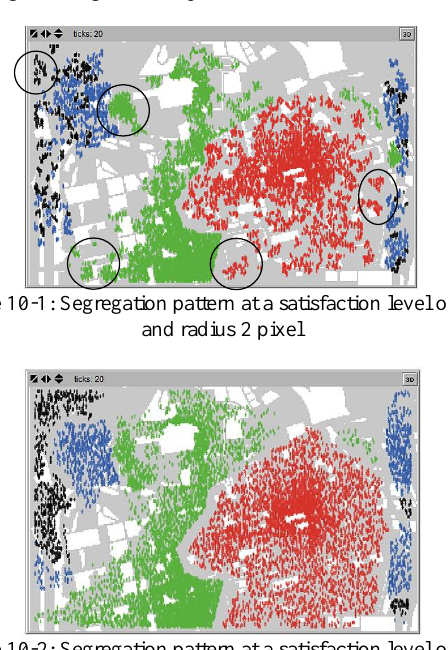
Figure 9: Segregation pattern- real world